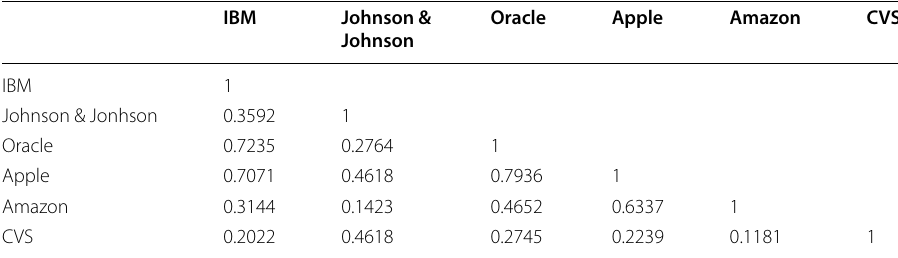
Table 4 Estimated � = [ σ m , n ] m , n ∈{ 1,2, ··· , N